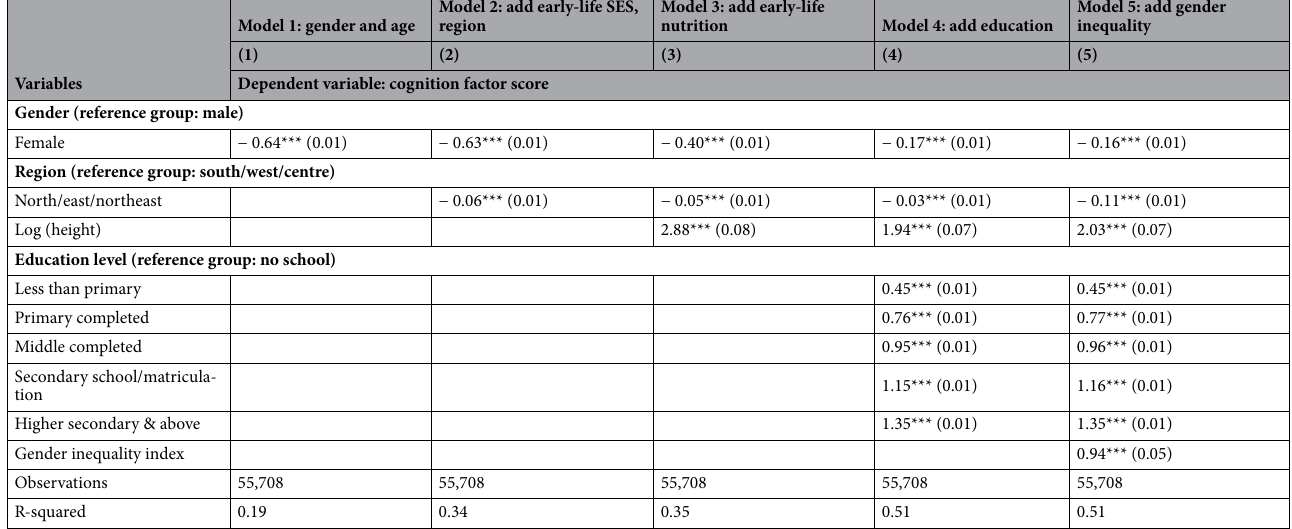
Table 3. Multivariate regression estimates. Data source Longitudinal Ageing Study in India (LASI), 2017– 2019. All estimates are weighted. Covariates in Model 1 are gender and age groups. Additional covariates in Model 2 are caste (two groups indicating SC/ST/OBC or general), religion (three groups indicating Hindu, Muslim, or other religions), whether respondent’s father attended any school, residence in rural versus urban area, and region of residence in India (two groups indicating whether state of residence is in South/West/ Centre or North/East/Northeast). Model 4 further controlled for logged value of respondent’s height.